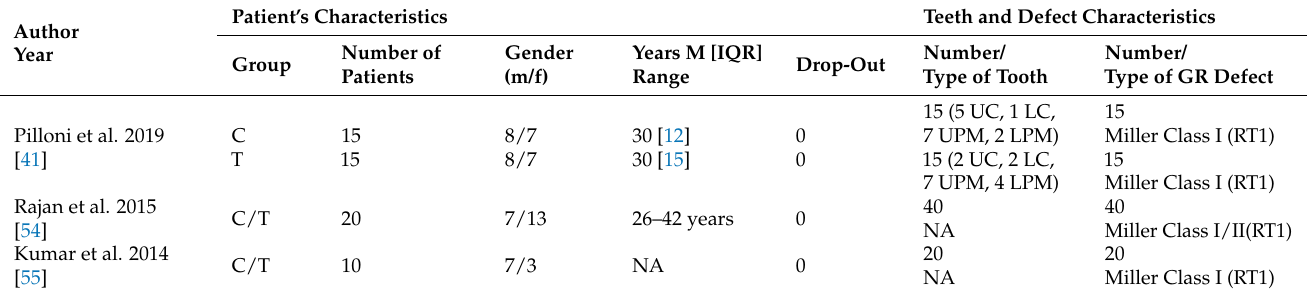
Table 2. Population